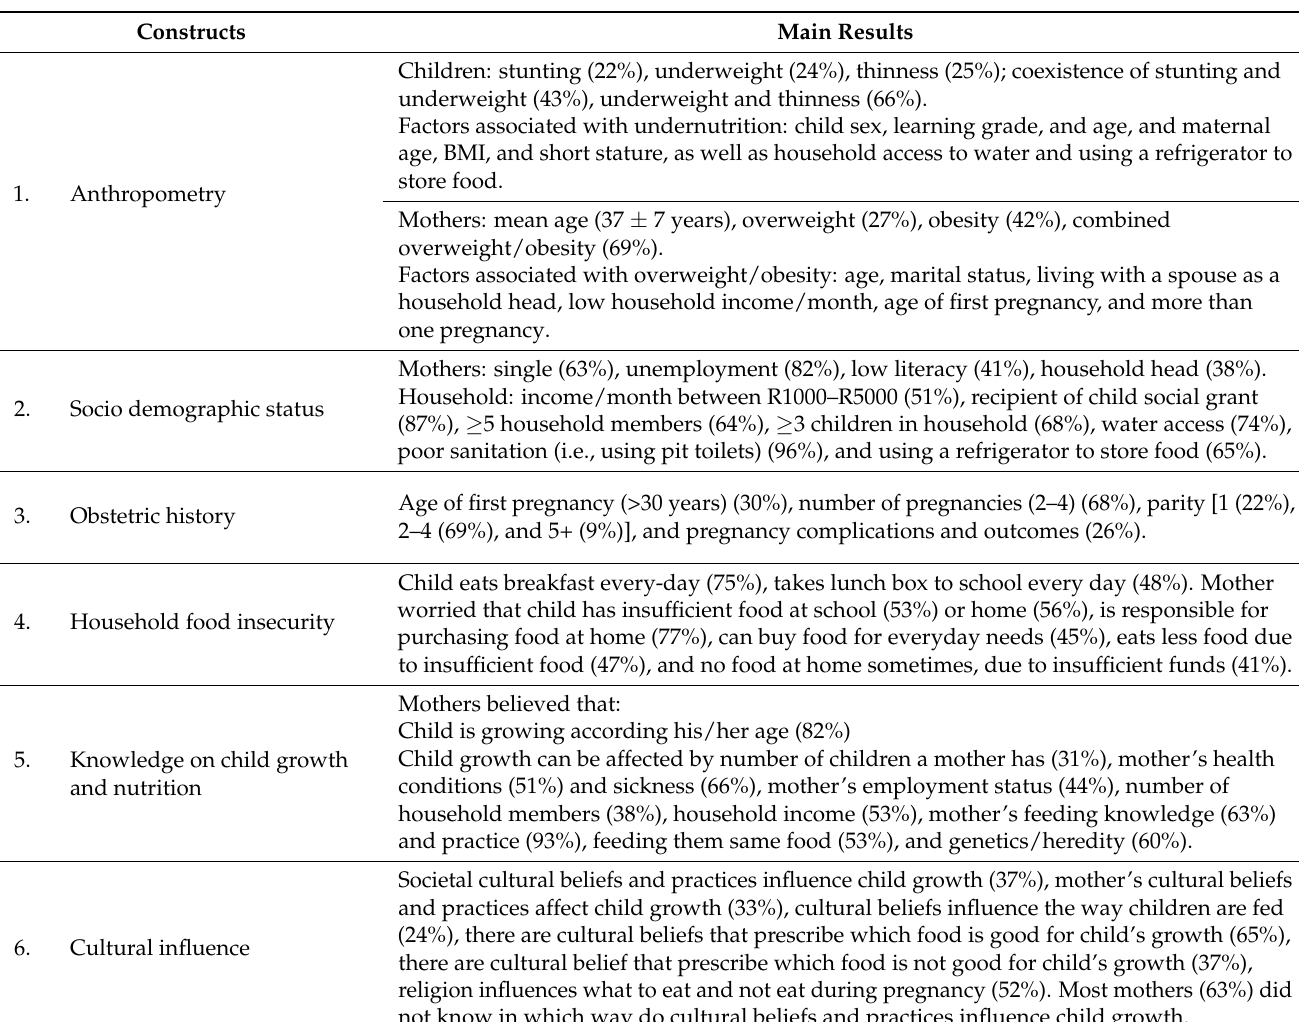
Table 1. Summary of the main quantitative results of children and their mothers with developed six